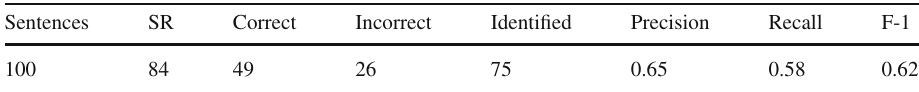
Table 8 Evaluation of extracted semantic relations